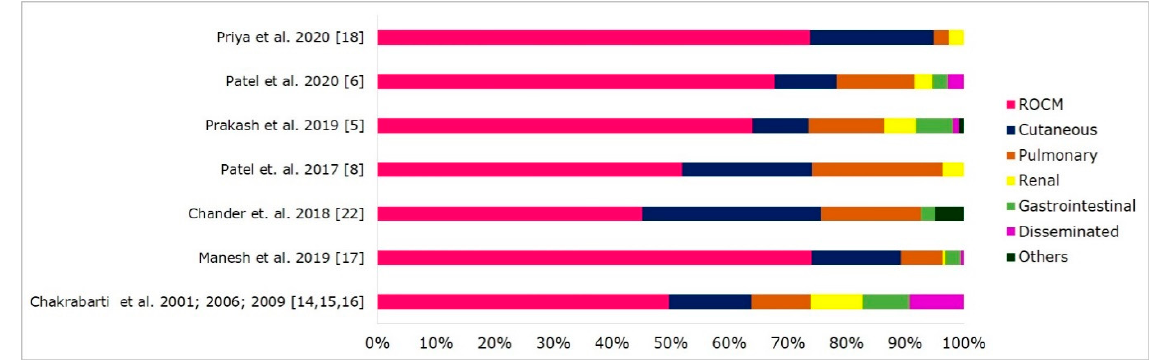
Figure 1. Clinical forms of mucormycosis in India. Abbreviations: ROCM, rhino-orbital-cerebral mucormycosis. Others included mucormycosis of the oral cavity, otitis media, subglottis, and bone infections.